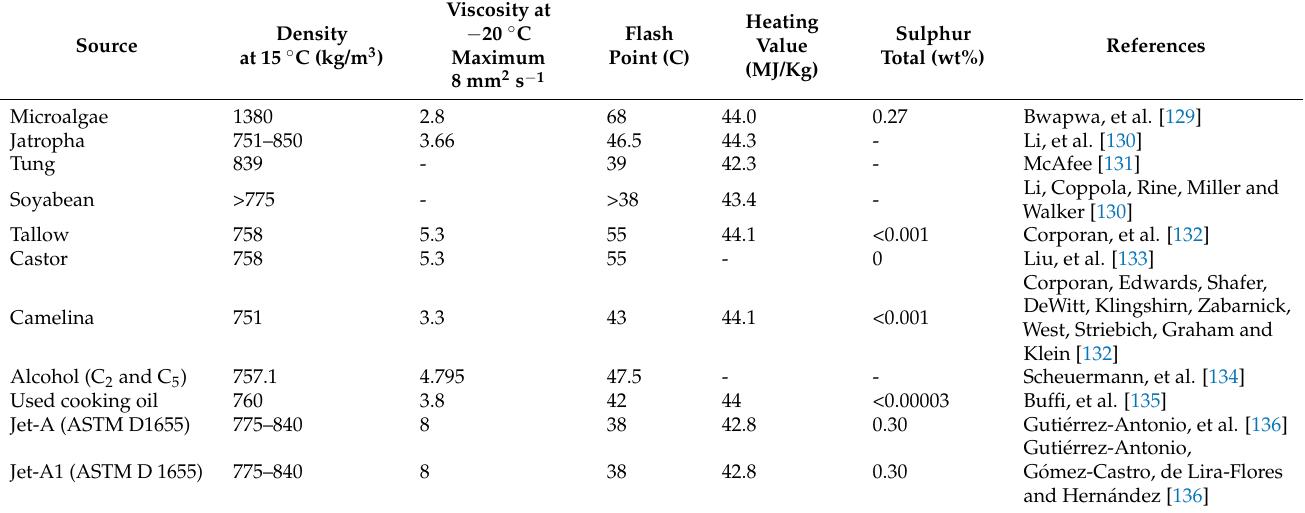
Table 3. Properties of microalgal bio-jet fuel compared to conventional bio-jet fuel.